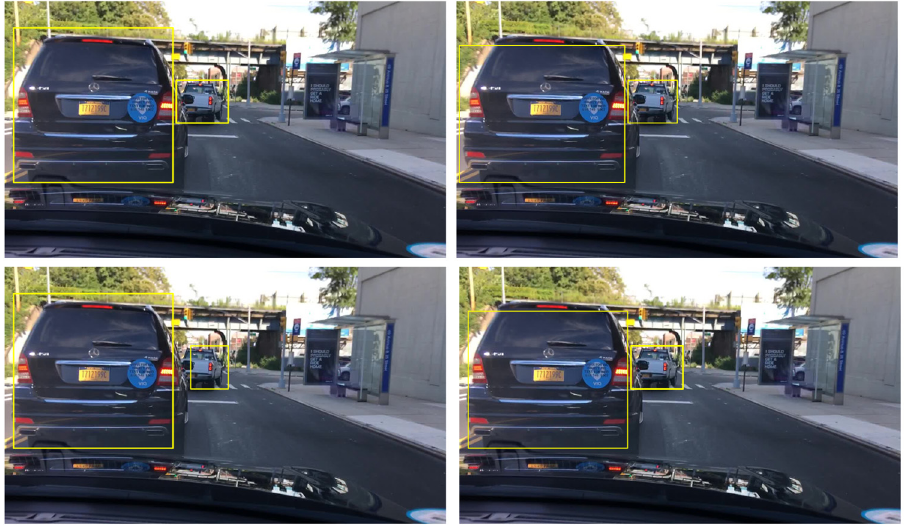
Figure 4. Data enhancement.